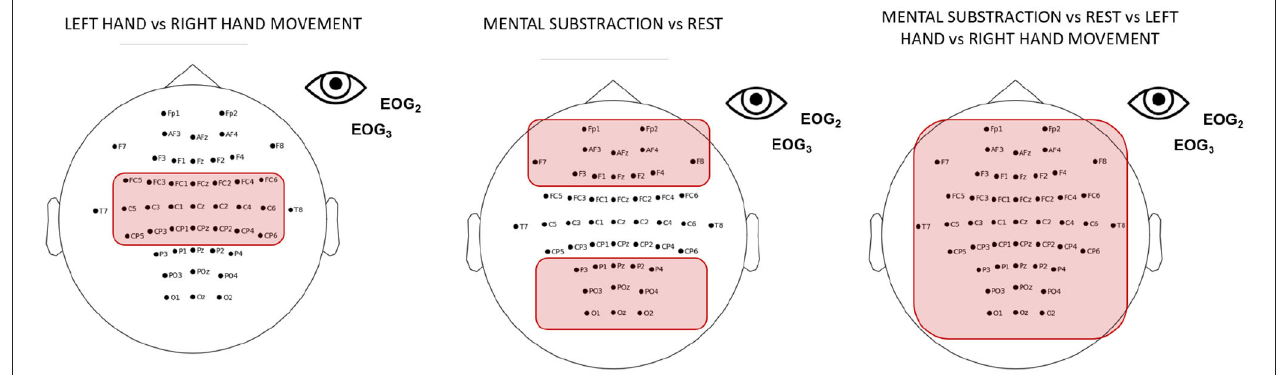
FIGURE 6 | Selected electrodes for neurophysiological analysis. From left to right : Electrodes of the motor area for the LEFT- vs. RIGHT-HAND motor imagery tasks, electrodes of the frontal, parietal and occipital areas for the MENTAL SUBTRACTION vs. REST mental tasks and all the electrodes for the 4-class BCI.